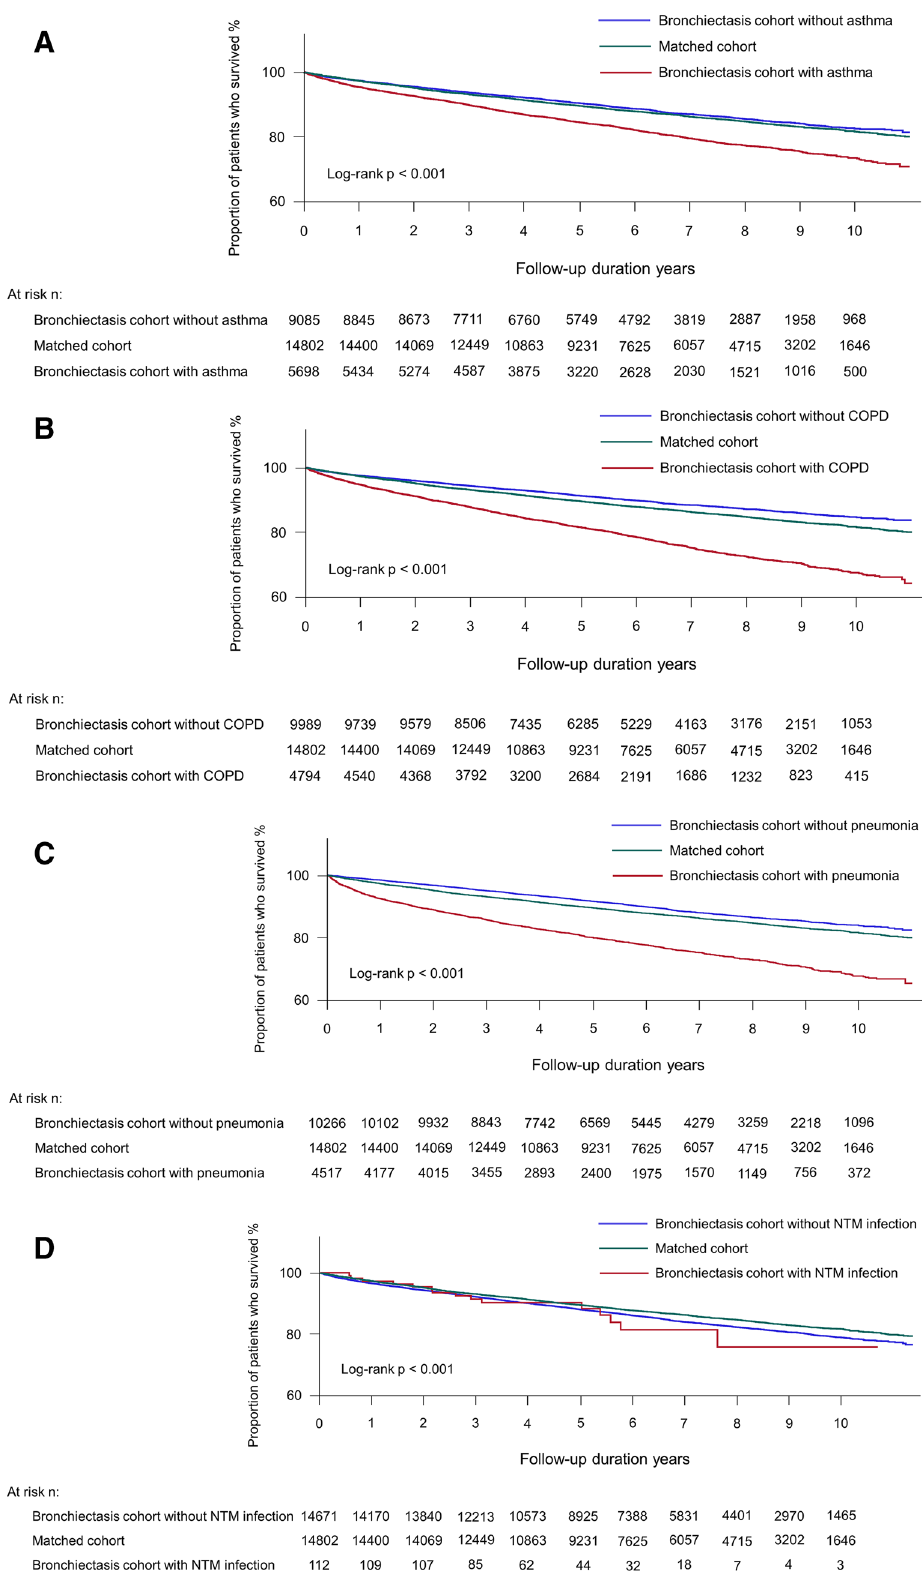
Figure 3. Kaplan–Meier survival analysis of the time to death in bronchiectasis patients with comorbidities, bronchiectasis patients without comorbidities, and those without bronchiectasis. ( A ) asthma, ( B ) COPD, ( C ) pneumonia, ( D ) NTM infection, ( E ) lung cancer, and ( F ) cardiovascular disease. COPD, chronic obstructive pulmonary disease; NTM, nontuberculous mycobacteria; CV,